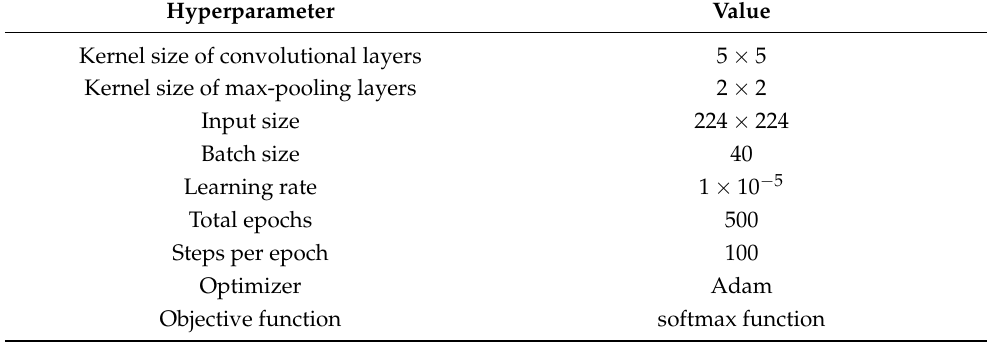
Table 4. Parameters for training CNN-based traffic accident classifier.